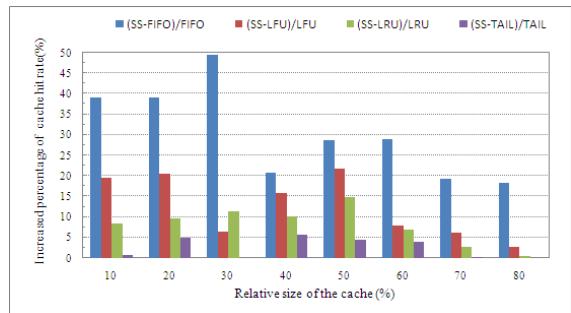
Figure1. Increased percentage of the tile-request cache hit rate